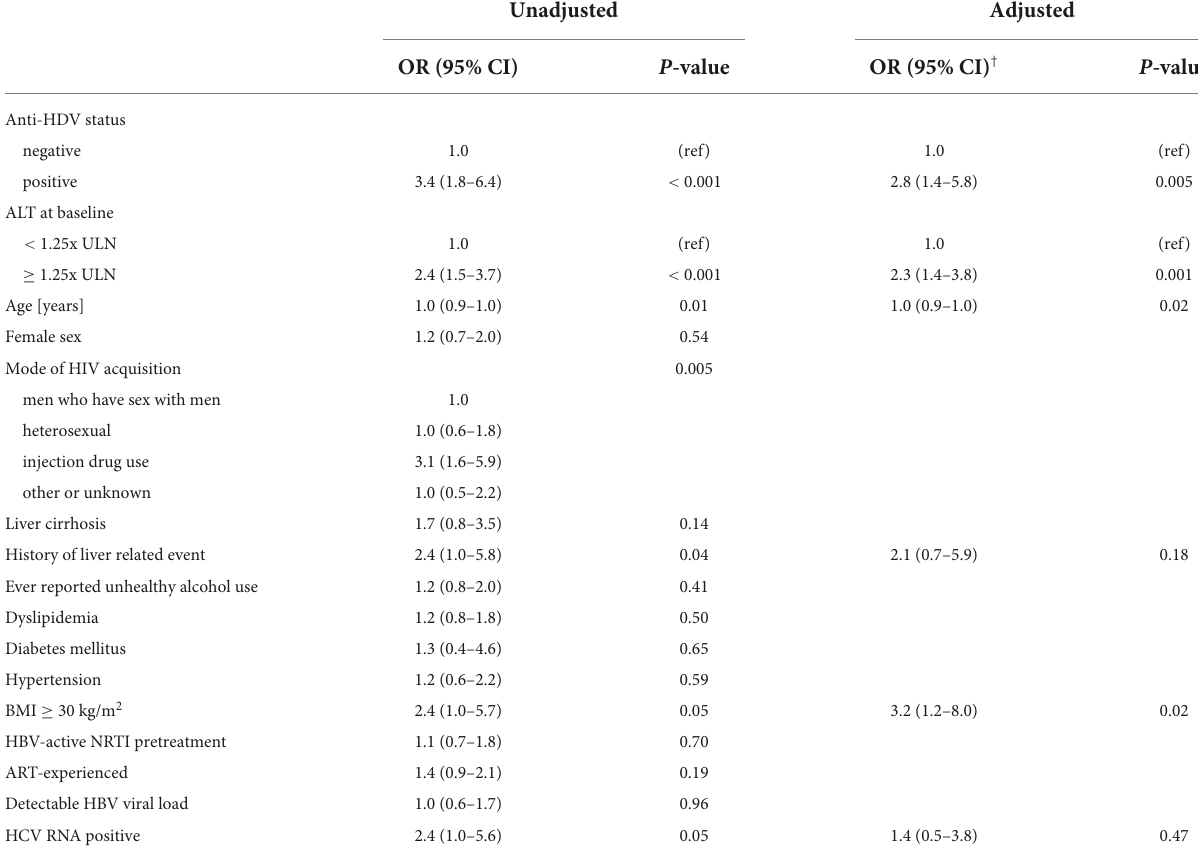
TABLE 2 Risk factors at start of tenofovir-containing antiretroviral therapy (ART) for alanine aminotransferase (ALT) elevation ( ≥ 1.25x ULN) after 5 years of tenofovir treatment.